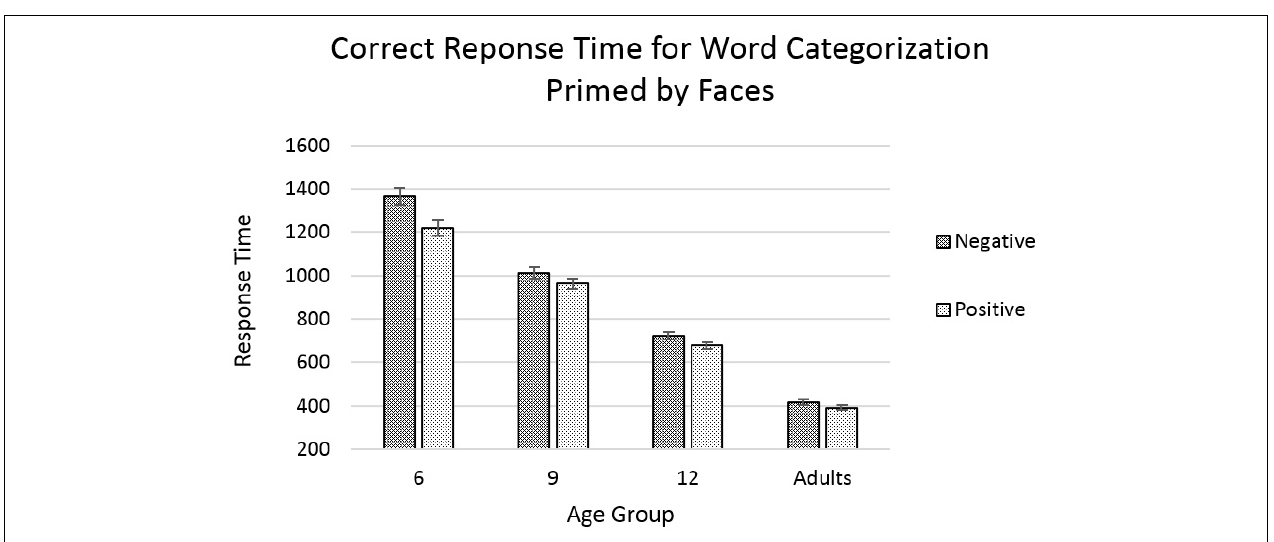
FIGURE 6 | Response time for correct trials categorizing word targets after priming by faces. Error bars represent standard error. No significant effects or interactions were found involving the factor of